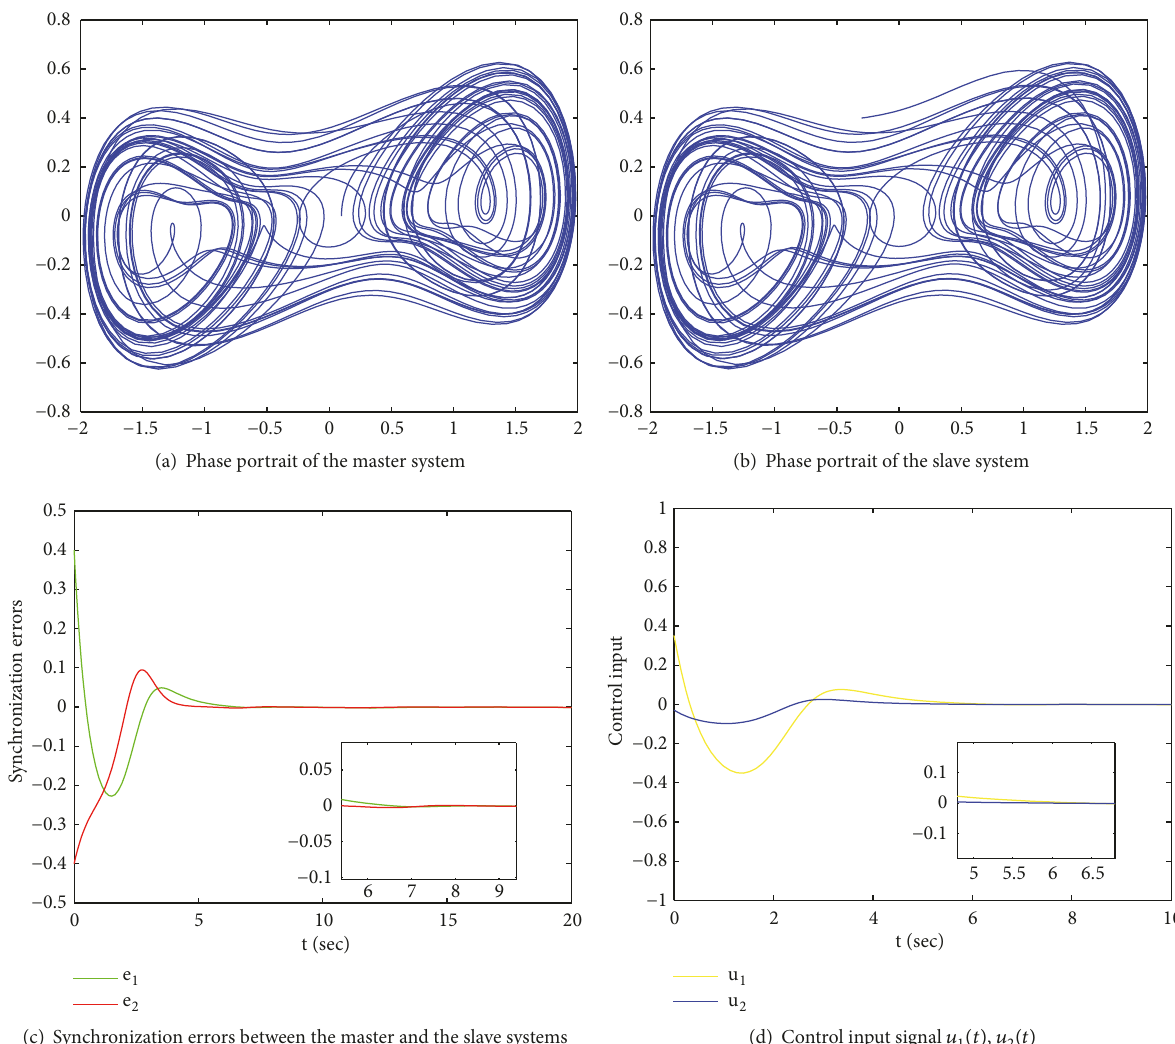
Figure 4: Behavior of the master-slave systems with control